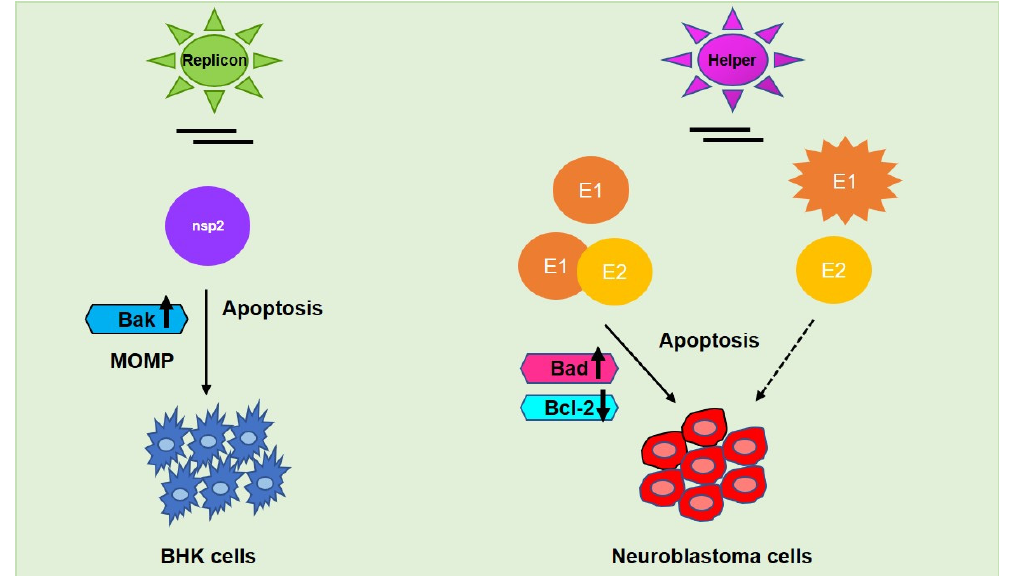
Figure 5. Alphaviral induced apoptosis facilitated by its respective non-structural protein nsp2 (encoded by replicon vector) in baby hamster kidney (BHK) fibroblasts and structural proteins E1/E2 (encoded by helper vector) in neuroblastoma and other cancer cells. E2 alone—could not mediate the same effect as E1 alone—or E1-E2 heterodimer in metastasis regulation whereas UV-inactivated SINV may commence oncolysis in the presence of E1, specifically in neuroblastoma cells. Upward arrow ↑ —upregulation; downward arrow ↓ —downregulation.